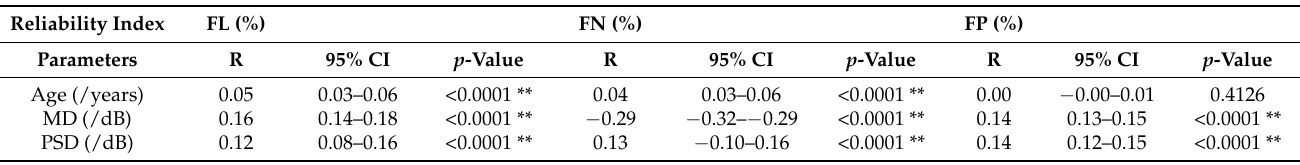
Table 6. Possible association between each reliability index and various parameters in subject 40 years and older using a mixed-effect model.